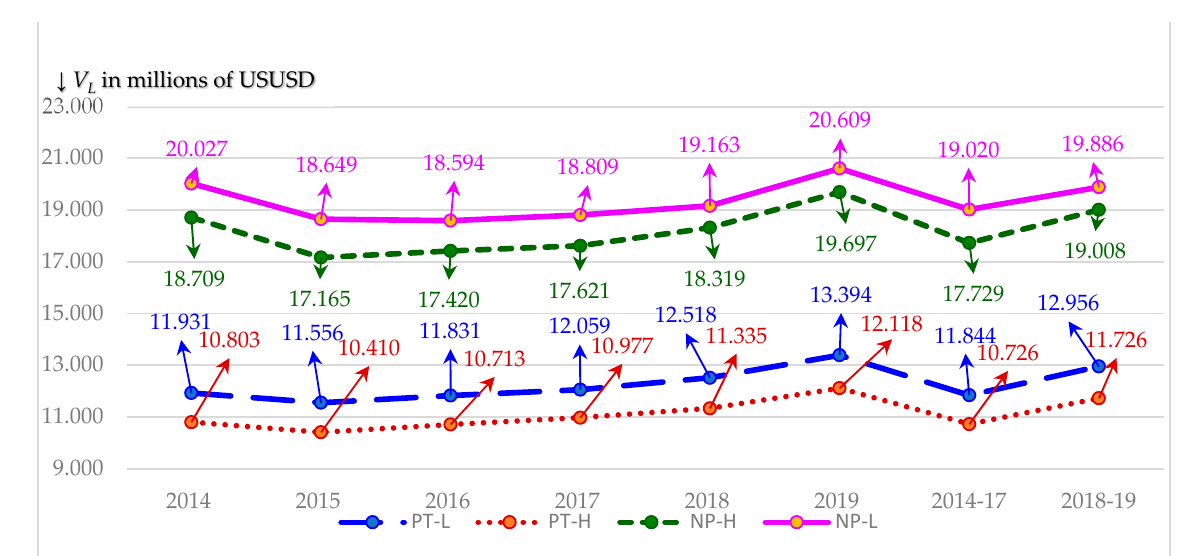
Figure 7. Maximum firm value ( max V L ) values are plotted along the vertical axis against six years (where annual credit spreads are different) and two periods (where annual credit spreads are averaged) along the horizontal axis. The four trajectories are NP- L trajectory, solid line; NP- H trajectory, small dashed line; PT- L trajectory, large dashed line; and, PT- H trajectory, dotted line. We use pre-TCJA tax rates for 2014–17 with 3.12% growth rate and TCJA tax rates for 2018–2019 with 3.90% growth rate. Both the low ( L ) and high ( H ) tax rates are used where the growth ( RE ) constraint sets in after Ba1 for nonprofits (NPs) and after Ba2 for pass-throughs (PTs). As seen in Table 6, the optimal credit rating ( OCR ) varies over time with an OCR of A3 for the last two years of 2018 and 2019 for both NPs and PTs.